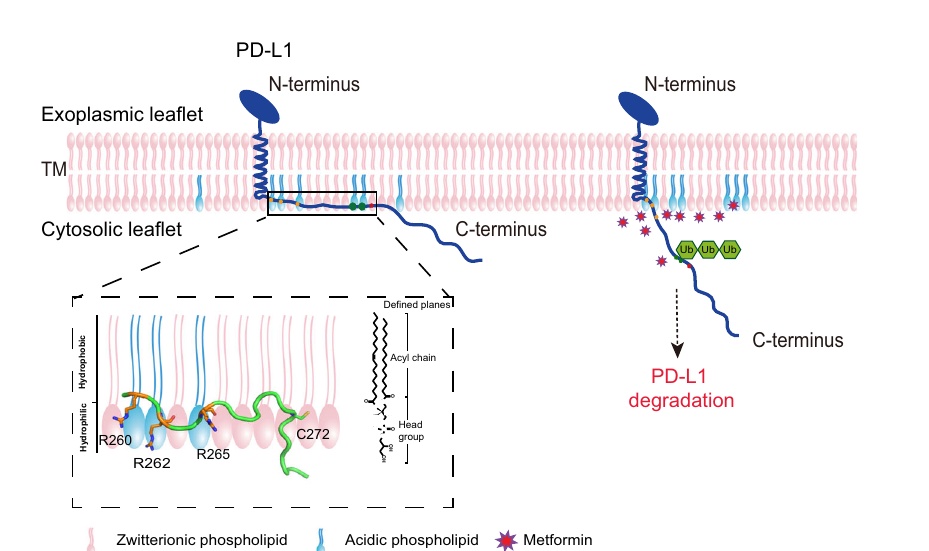
Fig. 6 A model for regulation of PD-L1 degradation by the membrane association of its cytoplasmic domain. PD-L1 on the cell surface is stabilized by the interaction of the cytoplasmic domain with the plasma membrane. Disruption of the electronic interactions between the acidic phospholipids in the membrane and the polybasic residues in the cytoplasmic domain unleashes the cytoplasmic domain from the membrane so that can be ubiquitinated, which marks the entire protein for the downstream degradation. The magni fi ed region shows a ribbon diagram of CD 260 – 290 shallowly embedded in one lea fl et of a lipid bilayer. The side chains of the three arginine residues and the cysteine at position 272 for palmitoylation are